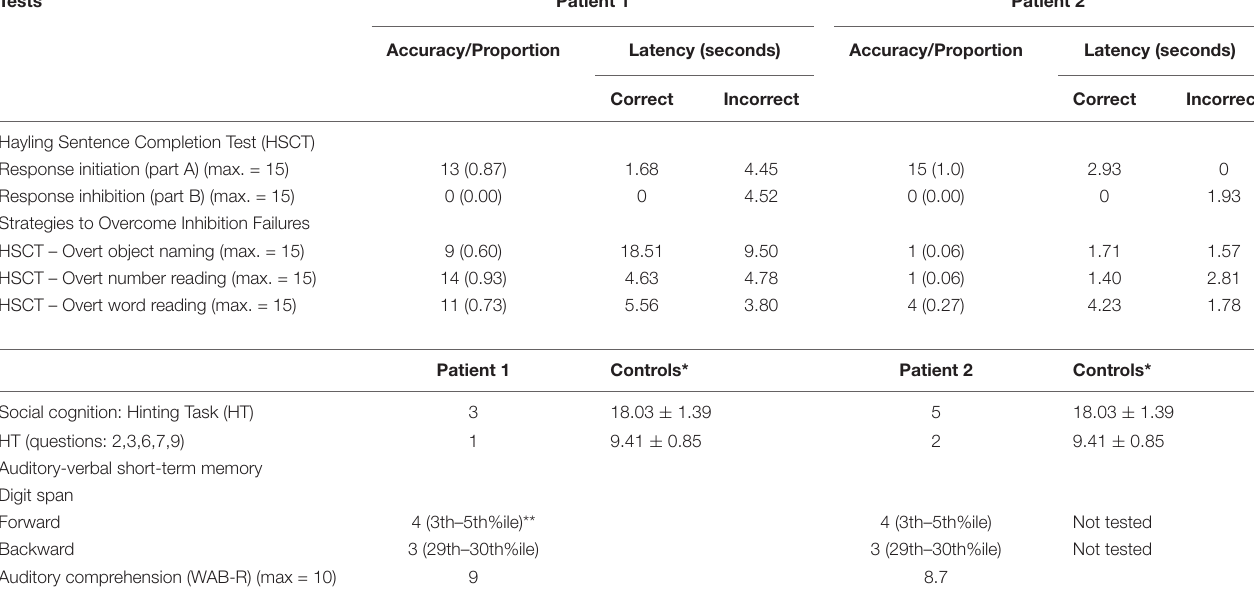
TABLE 4 | Multidimensional Testing of